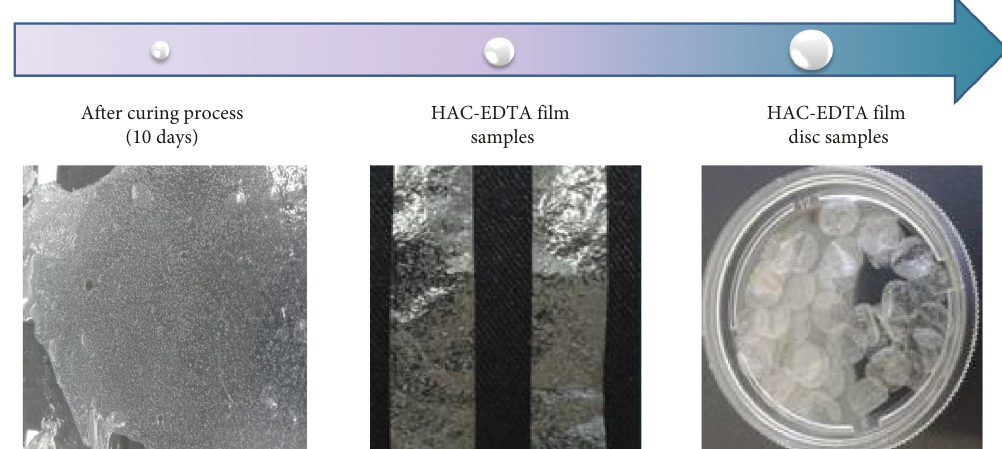
Figure 2: Preparation of HAC-EDTA (film and disc) samples after the curing